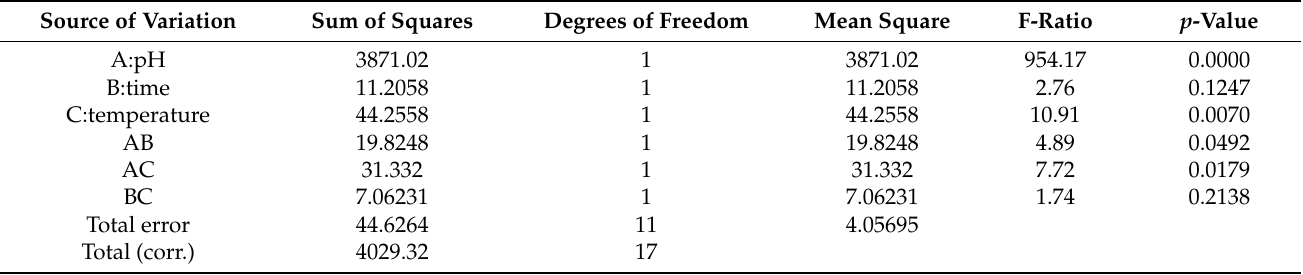
Table A1. Analysis of variance (ANOVA) corresponding to the 2 3 factorial design for Tahiti lime.